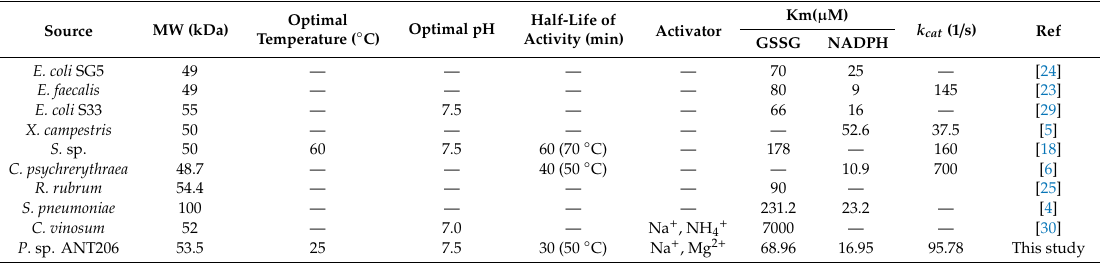
Table 3. Comparison information on GRs from prokaryotic